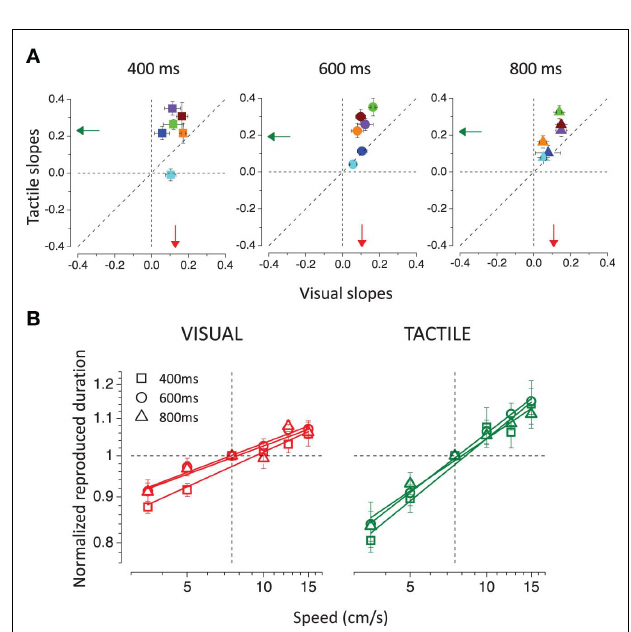
FIGURE 4 | (A) Tactile slopes plotted against visual slopes.The slopes were calculated, separately for each subject and condition, from the linear regression of the normalized reproduced durations (divided by the reproduced duration obtained for the 7.5-cm/s moving stimuli) as a function of speed. Different colors represent different subjects.The vertical and horizontal dashed lines indicate absence of dependence on speed, the diagonal shows equal dependence for vision and touch.The arrows show the averages for the visual (in red) and for the tactile (in green) conditions. (B) Normalized reproduced durations averaged across subjects are plotted as a function of speed for the visual (on the left) and tactile (on the right) stimuli. Different stimulus durations (400, 600, and 800ms) are represented by different